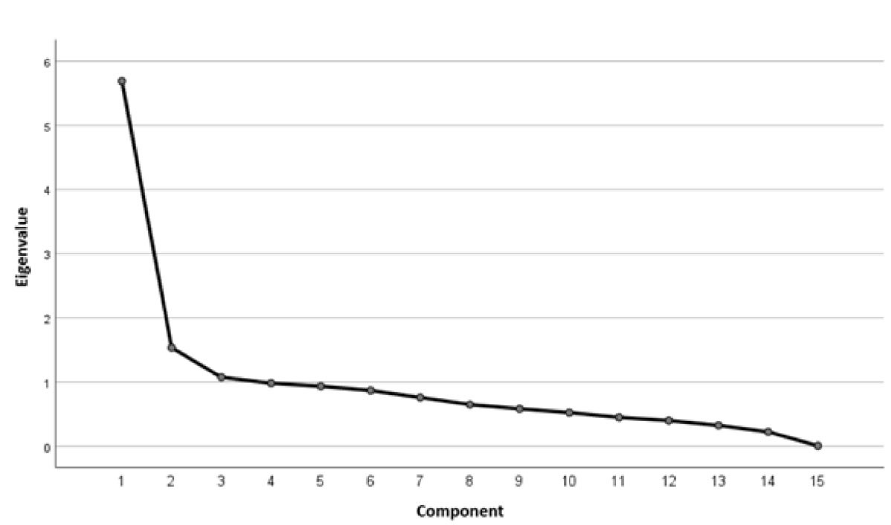
Figure 1. Screen